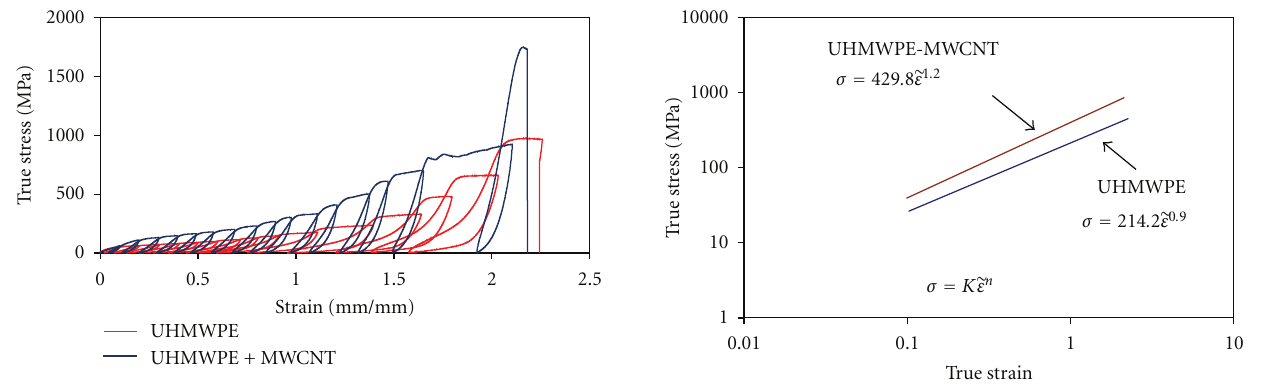
Figure 4: Log-log plot of true stress-true